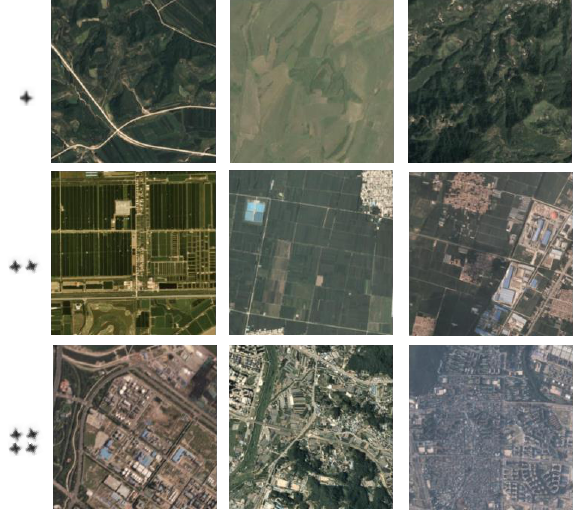
Figure 2. Instances of daytime satellite imagery with different corresponding nightlight intensity levels in 2016. From top to bottom: images with low-level, medium-level, and high-level nighttime light intensity.